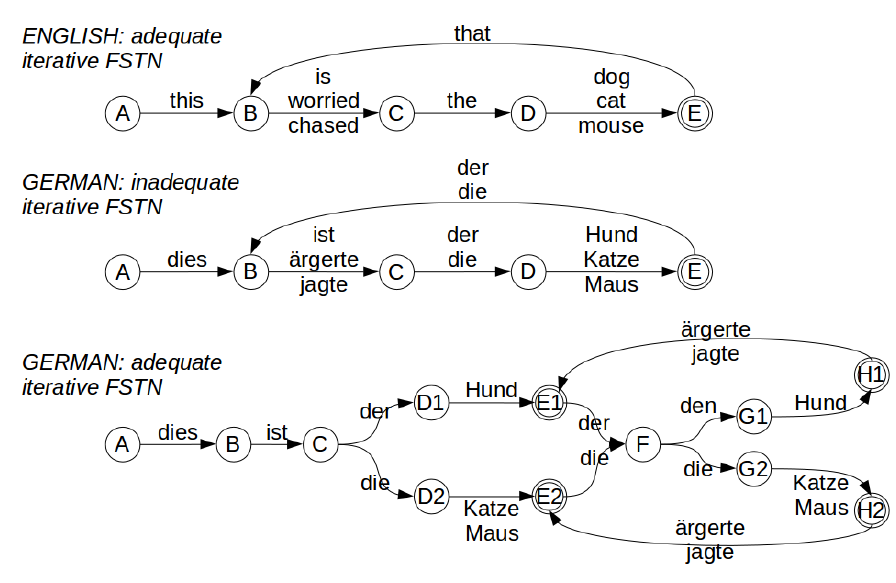
Figure 5: Finite state solutions for subject-verb congruence in English and German.